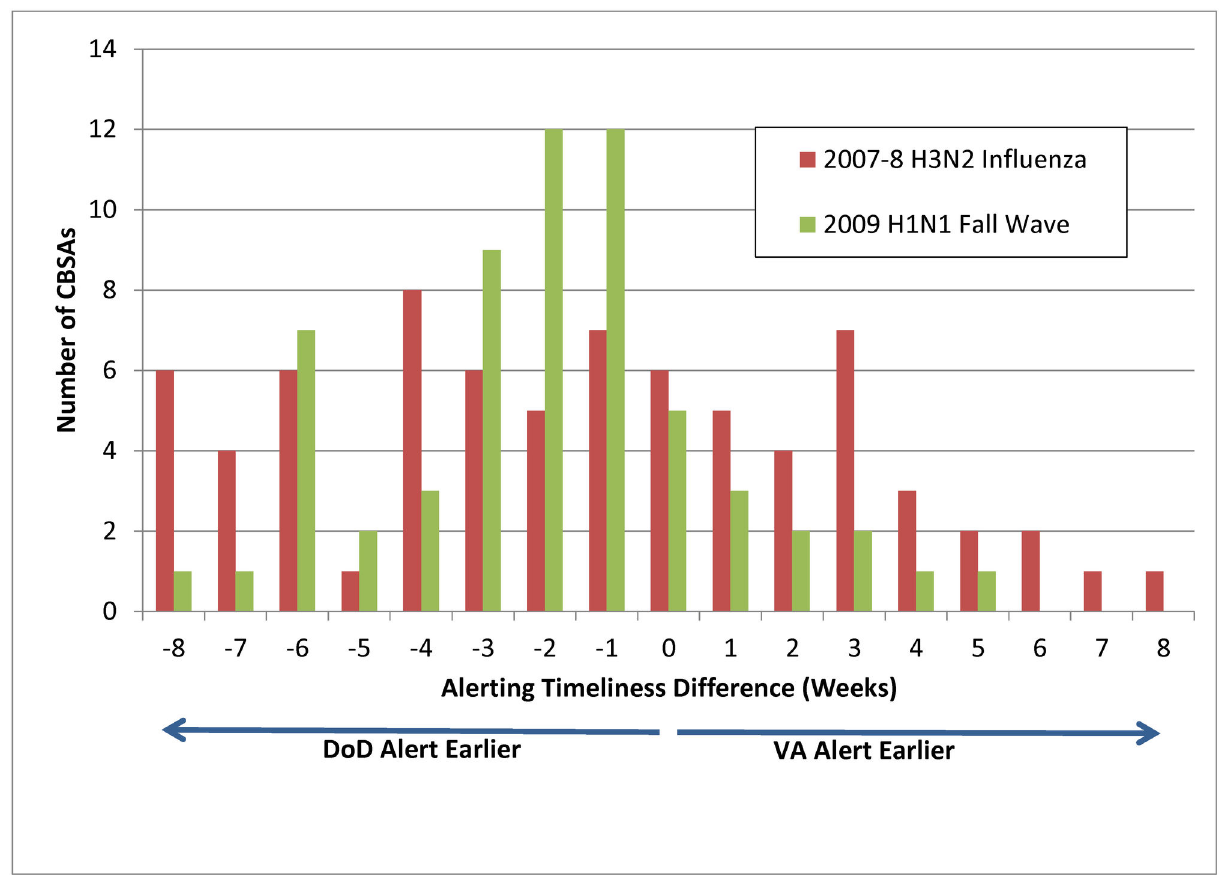
Figure 2. Delay in weeks between Department of Defense and Veterans Affairs alerting for two influenza seasons. The height of each bar is the number of Core-Based Statistical Areas (CBSAs). The x-axis is delay lengths in weeks, with the x-axis origin indicating no alerting delay between systems, negative delays indicating earlier DoD alerting and positive delays for earlier VA alerting. Red bars show relative timeliness for the 2007-8 H3N2 Influenza epidemic, green bars show timeliness for the 2009 novel H1N1 fall